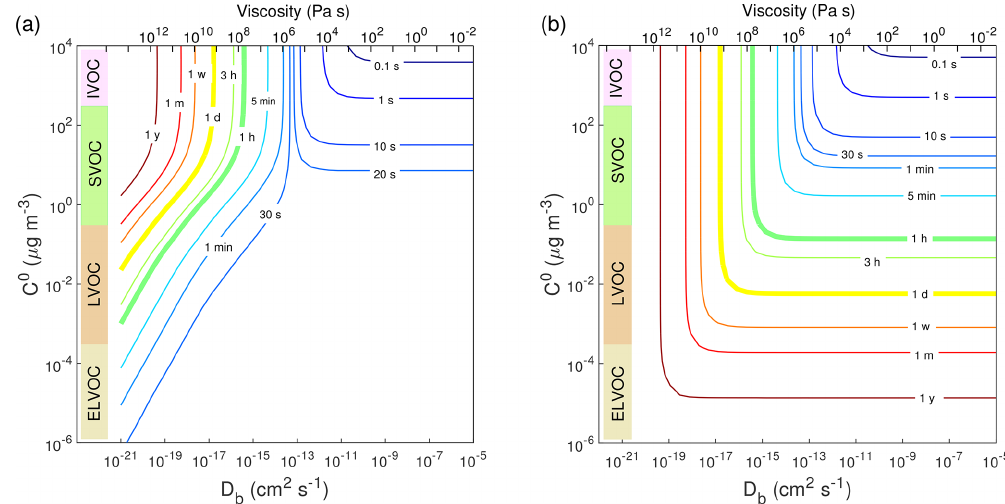
Figure 4. Contour plot of equilibration timescale ( τ eq ) as a function of bulk diffusivity ( D b ) and saturation mass concentration ( C 0 ) for (a) condensation in the closed system and (b) evaporation in the open system. The initial mass concentration of preexisting particles is set to 20µgm − 3 with the number concentrations of 3 × 10 4 cm − 3 and the initial particle diameter of 100nm. Viscosity is calculated from the Stokes–Einstein equation, assuming the effective molecular radius of 10 − 8 cm at T of